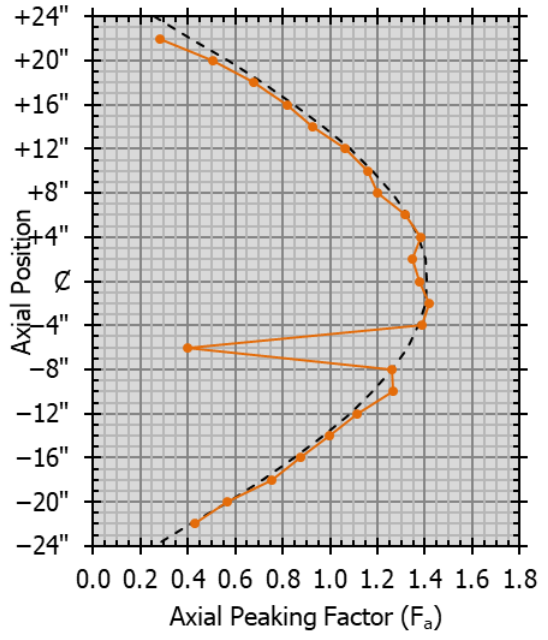
Figure 7. Example Erroneous Profile